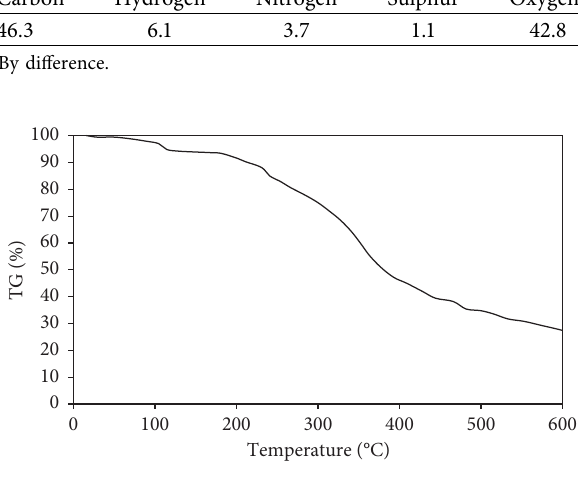
Figure 1: Thermogravimetric curve.